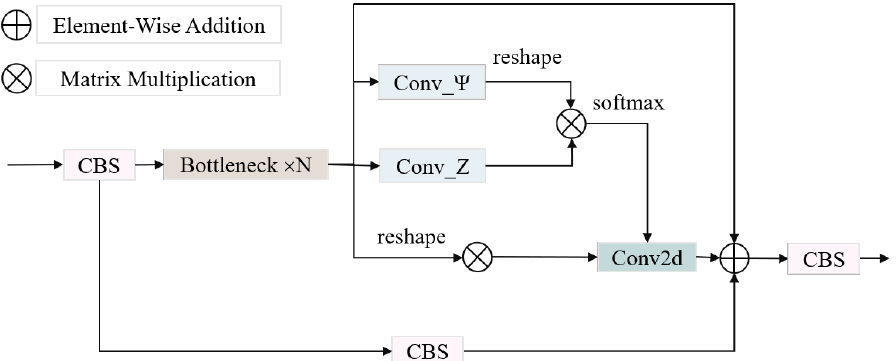
Figure 3. The network structure diagram of effective feature enhancement.